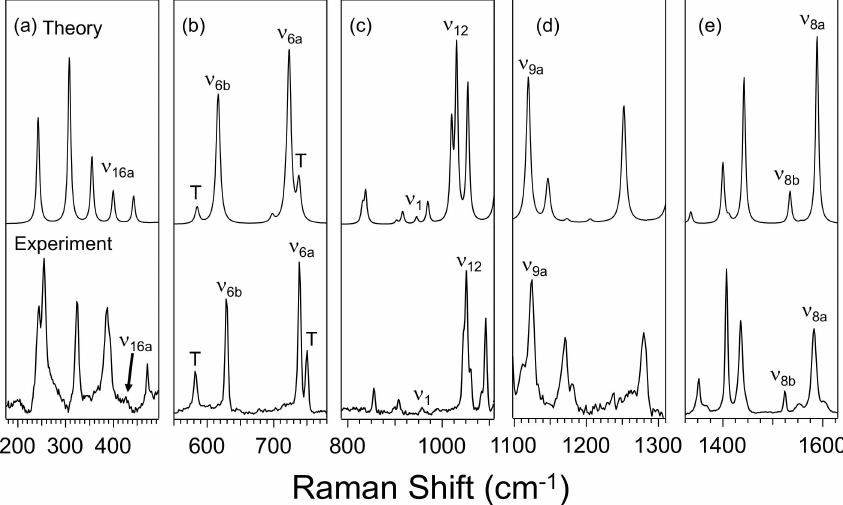
Figure 10. Experimental Raman spectra of PrmT (bottom) compared to its simulated spectrum (top). Peaks in the 550–750 cm − 1 window that are readily assigned to thiophene vibrations are denoted by